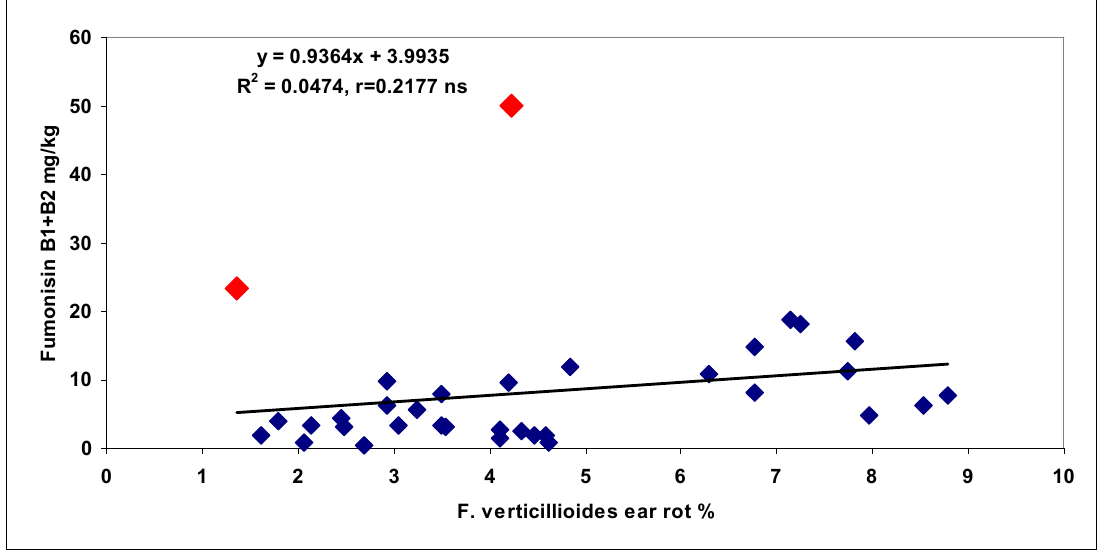
Figure 8. Regression between Fusarium verticillioides ear rot severity (%) following toothpick inoculation and fumonisin contamination ( n = 34), Szeged, 2010–2011, n = 34. LSD 5% for fumonisin B1 + B2 between genotypes: 13.60. Red highlighted Difference between 50.07 and calculated DON by the linear function (7.95) is 50.42 (hybrid Kenez) 42.12 that is higher than LSD 5% 13.60. For (ISH303) 23.34 mg/kg is the infected fumonisin content, 5.25 mg/kg is the data point on the regression line, the difference is 17.98, higher than the LSD 5% limit is. Therefore, the fumonisin overproduction is proven. Statistical method: Built-in Excel function for regression calculation.